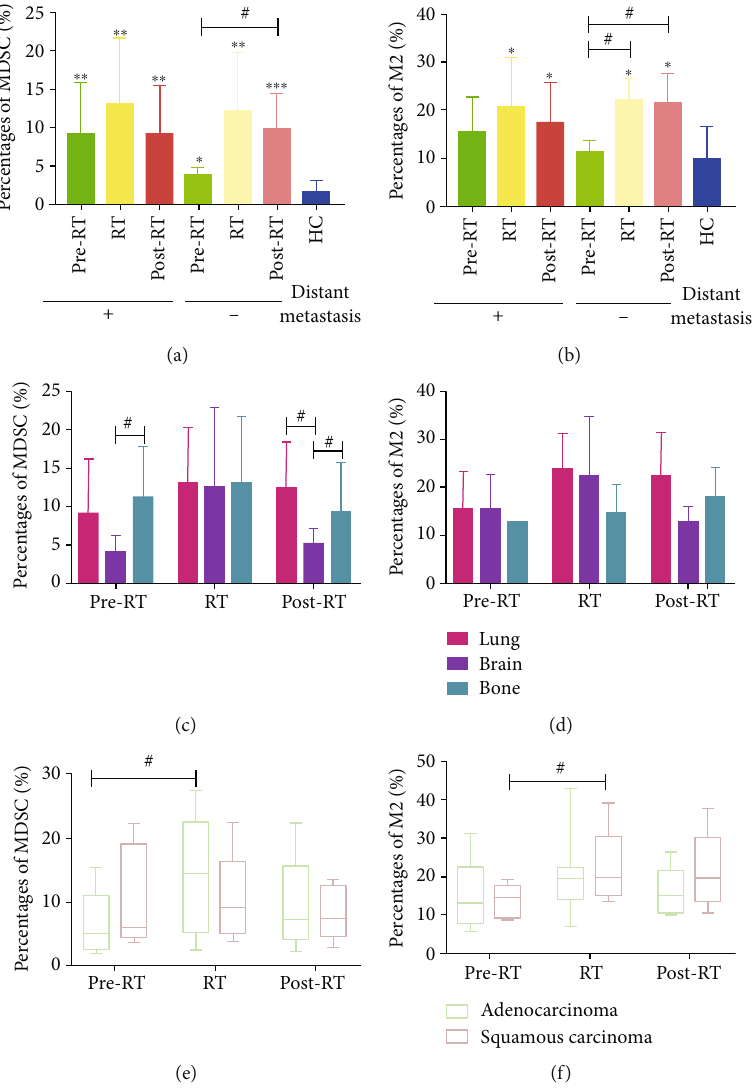
Figure 3: The percentages of MDSCs and CD68 + CD163 + M2-like macrophages of NSCLC patients in various clinical characteristics. (a, b) The proportions of MDSCs and CD68 + CD163 + M2-like macrophages in NSCLC patients with or without metastasis. (c, d) The percentages of MDSCs and CD68 + CD163 + M2-like macrophages in NSCLC patients with a di ff erent radiotherapy area. (e, f) The proportions of MDSCs and CD68 + CD163 + M2-like macrophages in NSCLC patients with diverse pathologic types. ∗ p < 0 : 05 , ∗∗ p < 0 : 01 , and ∗∗∗ p < 0 : 001 , compared to the HC group in two-tailed Student ’ s t -test. # p < 0 : 05 . The bars denote mean ± SD